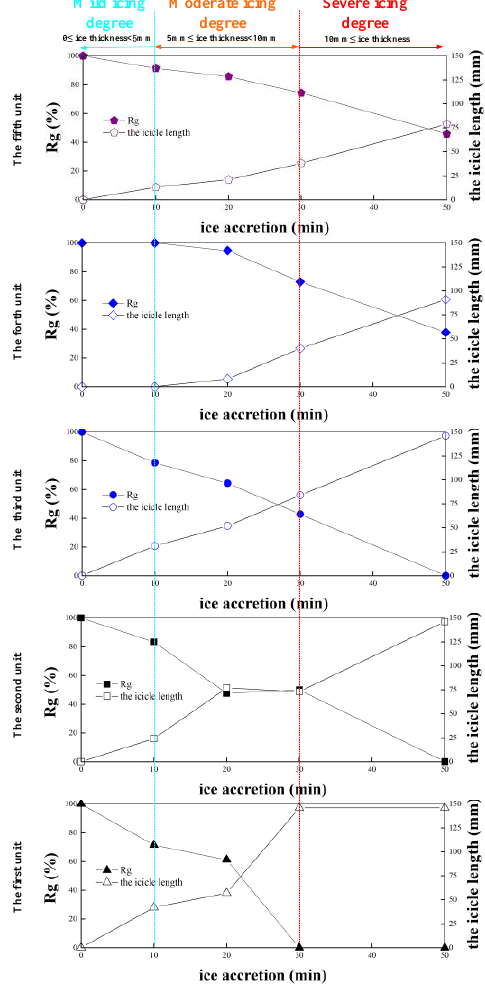
Figure 8. The variation of icicle length and Rg during the ice accretion regime.